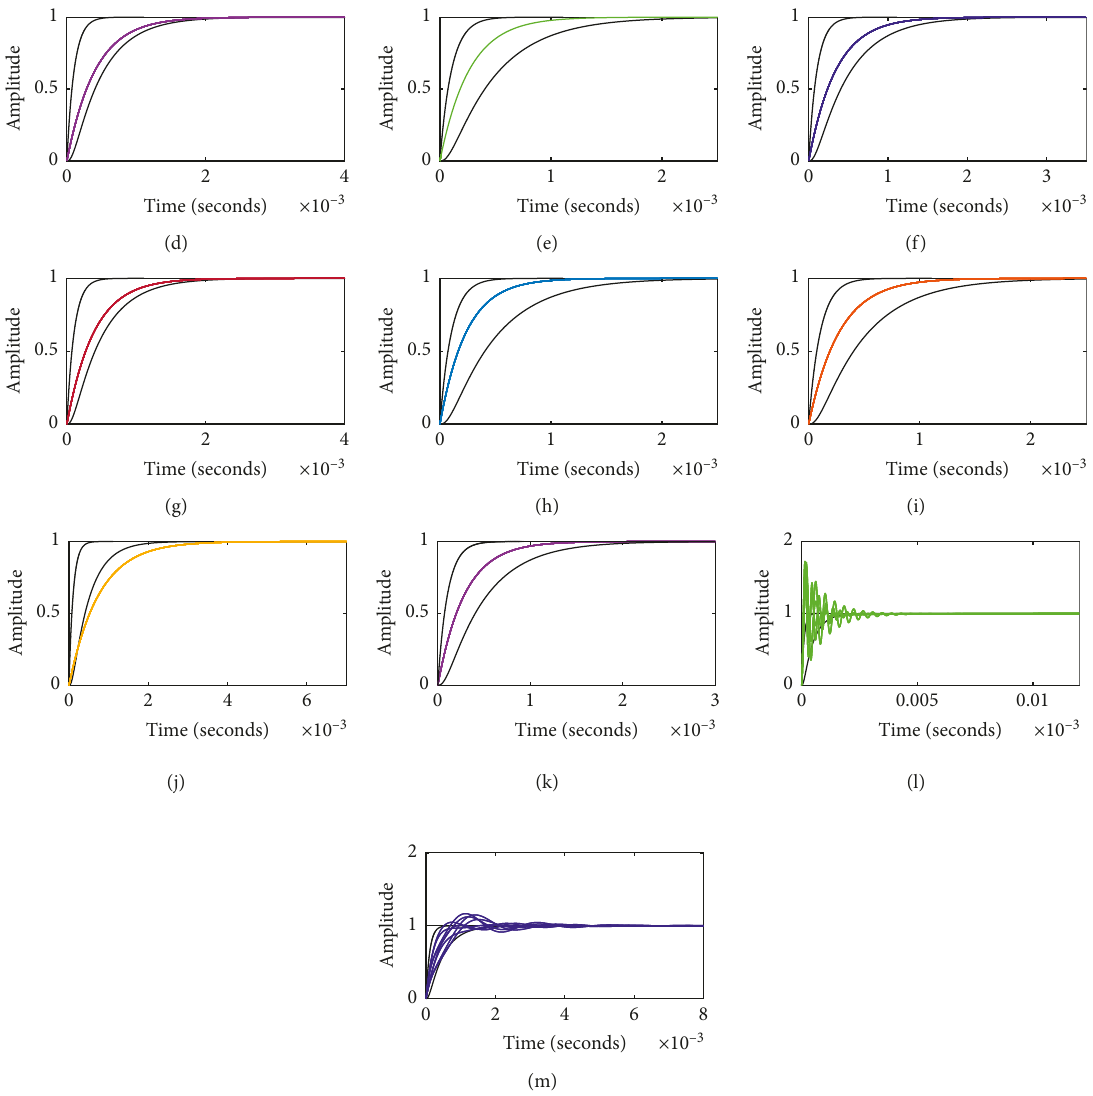
Figure 5: Compared time-domain worst case response of the closed-loop system: (a) BA; (b) FPA; (c) ABC; (d) BBO; (e) HS; (f) DE; (g) ICA; (h) IWO; (i) TBLO; (j) ACO; (k) Ibarra et al; (l) Zeigler–Nichols; (m)